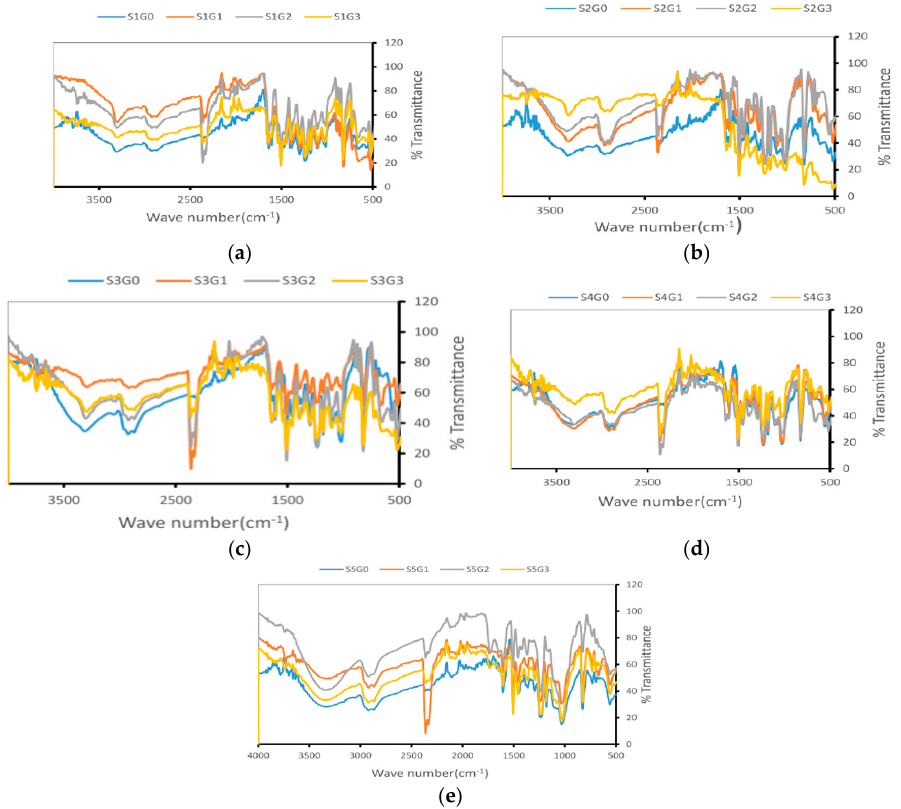
Figure 11. The FTIR spectra of Kevlar, Cocos nucifera sheath, and hybrid composites. ( a ) S1; ( b ) S2; ( c ) S3; ( d ) S4; and ( e ) S5